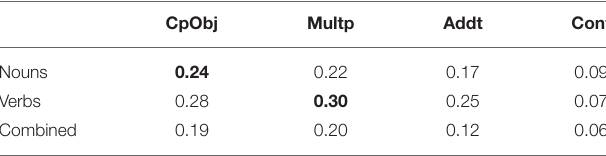
TABLE 6 | Accuracy results for the term/definition comparison task, Kartsaklis et al. [26].